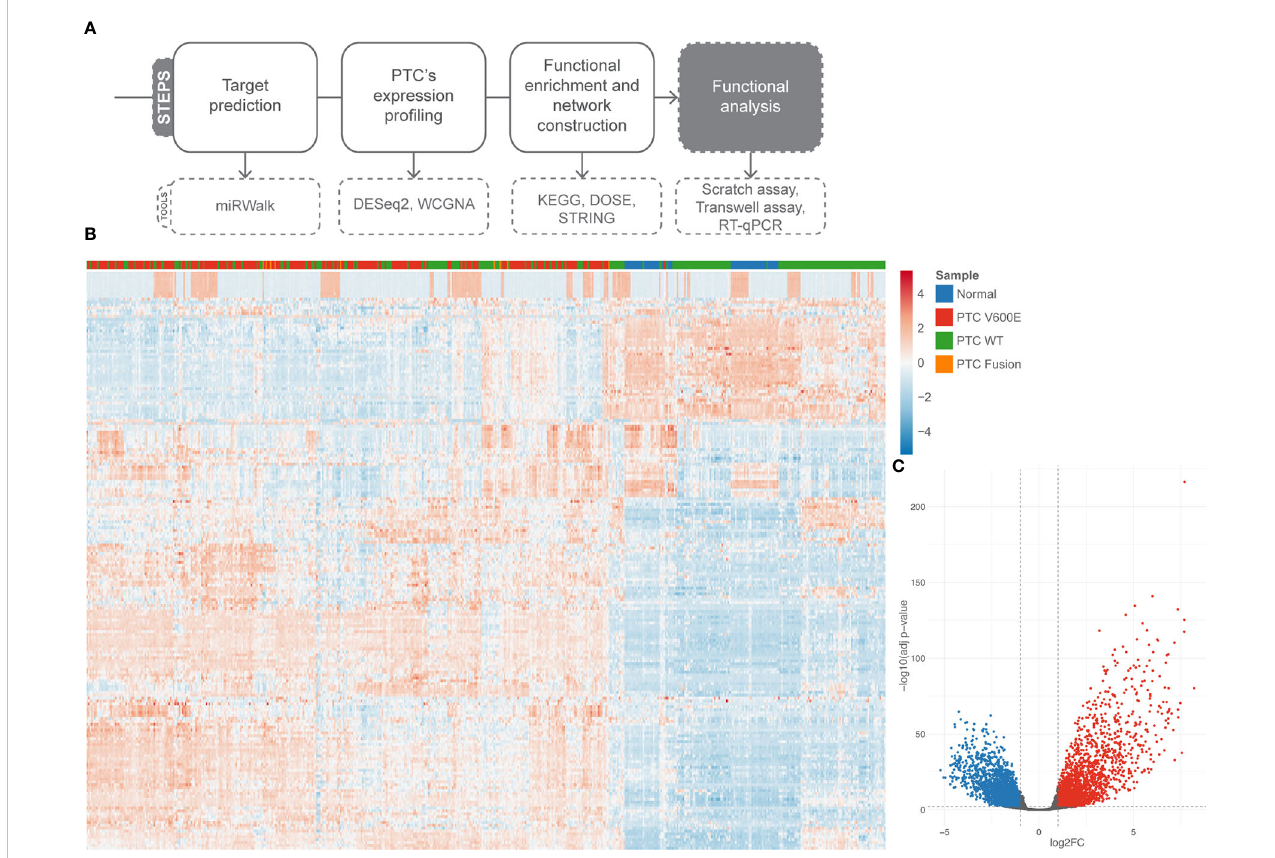
FIGURE 2 Differentially expressed genes in PTC. (A) Pipeline of investigation shows, brie fl y, the steps we followed to validate miR-495-3p in fl uence on PTC progression. (B) Heatmap of the top 200 DEG (abs(log2FC) > 0.58 and adjusted p value < 0.01). (C) Volcano plot of DGE analysis. Upregulated genes are shown in red and down regulated genes in